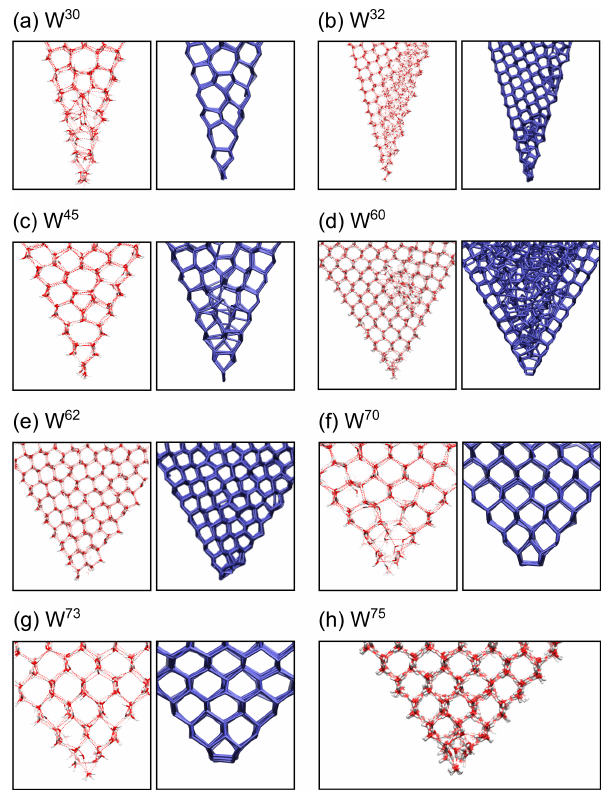
Figure 8. Examples of atomistic details of ice structures at the bot- tom of the wedge systems for the TIP4P/Ice and the mW water mod- els for (a) W 30 , (b) W 32 , (c) W 45 , (d) W 60 , (e) W 62 , (f) W 70 , (g) W 73 and (h) W 75 . TIP4P/Ice molecules are shown as red and white sticks, and hydrogen bonds are shown as dashed red lines. For the mW model, the hydrogen bond network is shown as blue